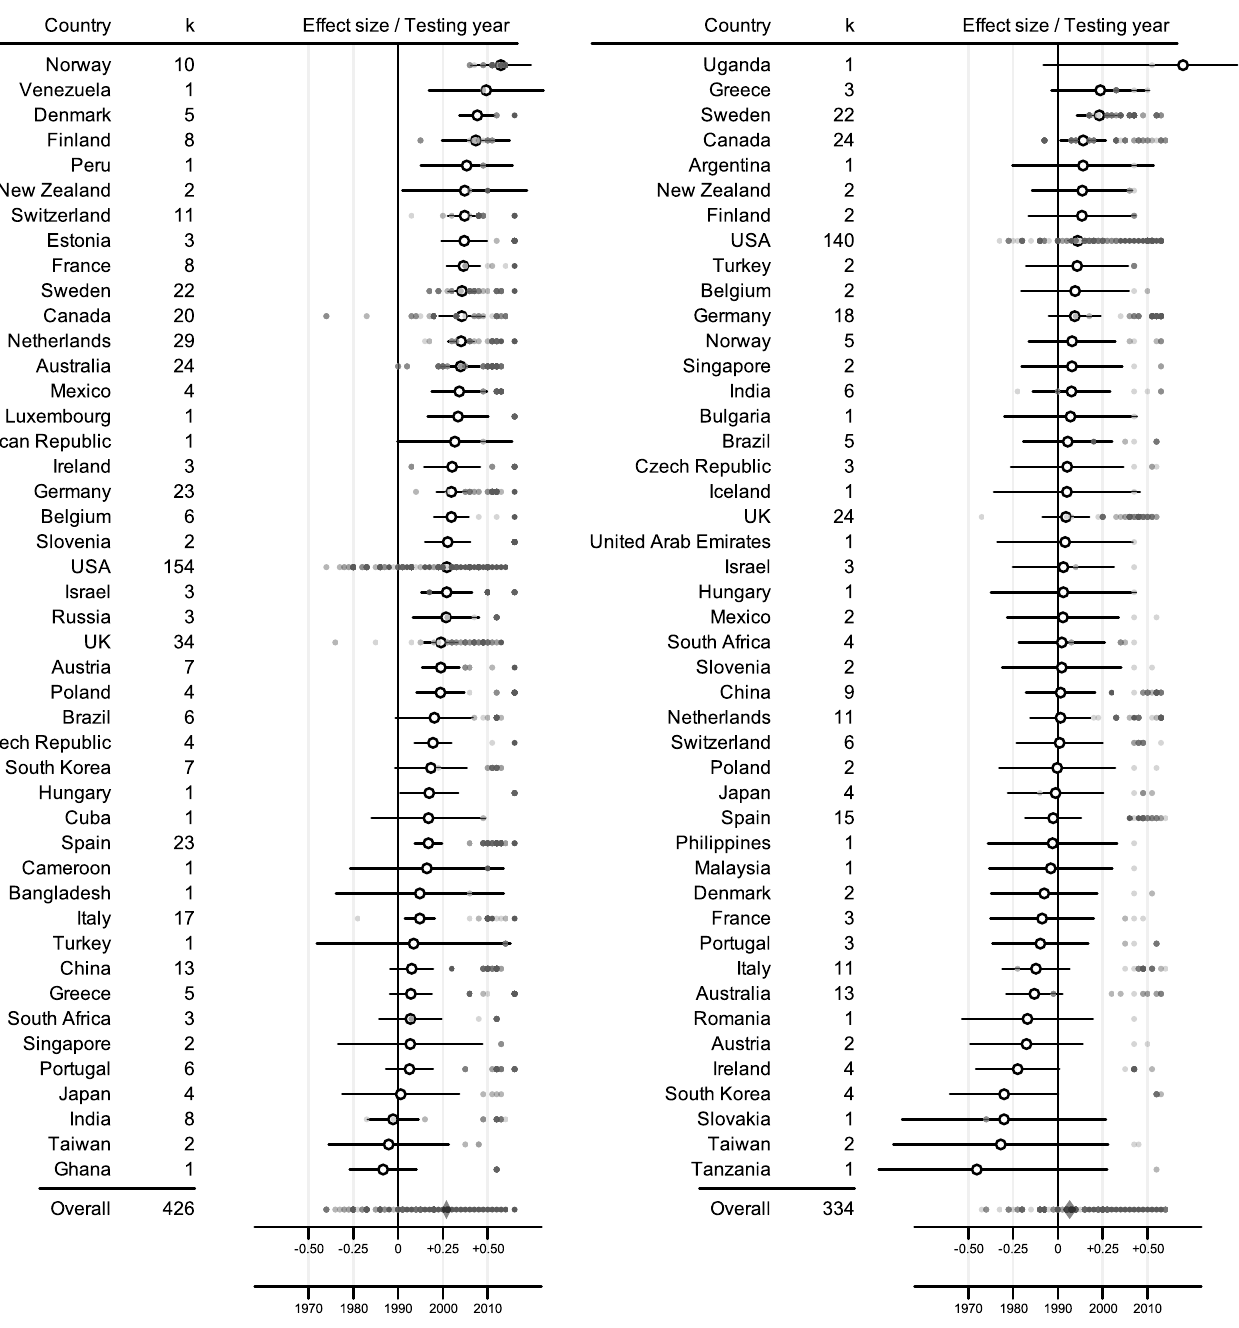
Fig 1. Effect size estimates for each country for both task categories. Forest plot describing the variation in sex differences in (a) Verbal and (b) Other episodic memory tasks across the (a) 45 and (b) 45 countries used in the analyses, with k = number of studies available for each country. Cohen’s d (unfilled circles) is presented on the x-axis, with error bars describing the 95% confidence intervals (notice that some error bars have been truncated). Filled circles indicate the year each study was carried